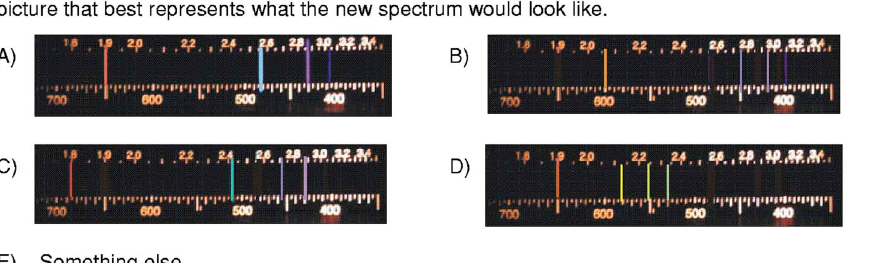
FIG. 1. (cid:1) Color (cid:2) Graphical and pictorial representations of the spectroscopy quiz given in Phys- ics